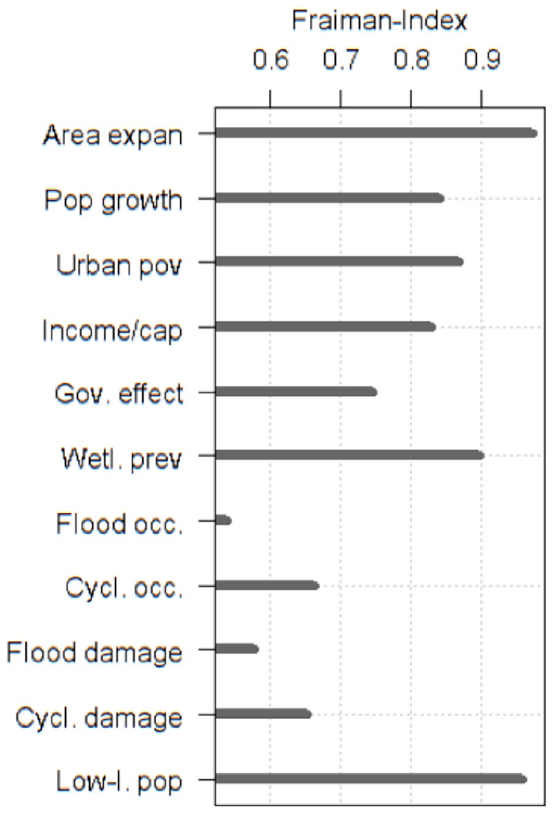
Fig 6. The Fraiman measure for each indicator. The values are between 0 and 1 and express the relative importance of each indicator in separating the clusters. The smaller the value, the more important the indicator is. The value shows the percentage of grid cells identically assigned when the corresponding indicator is blinded. Indicator names are abbreviated—Area expan: Urban expansion; Pop growth: (Rapid) urban population increase; Urban pov: Slum population level; Income/cap: Average per capita income; Gov. effect: Government effectiveness; Wetl. Prev: Wetlands prevalence; Flood occ.: Flood occurrence; Cycl. occ.: Cyclone occurrence; Flood damage: ibid.; Cycl. damage: ibid.; Low-l. pop: Low-lying